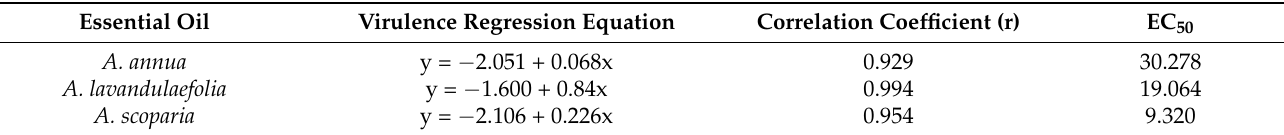
Table 1. EC 50 value of three essential oils against C. gloeosprioides , by the agardiffusion method ( µ L/mL). Essential